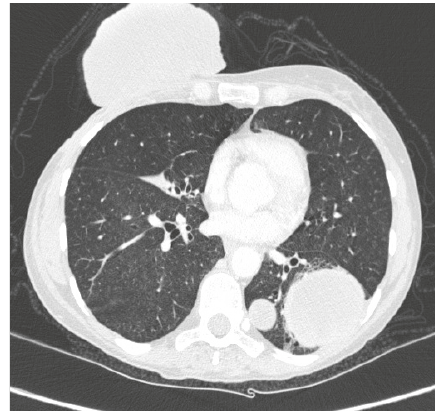
Figure 8: Chest tomography in the rehospitalization.